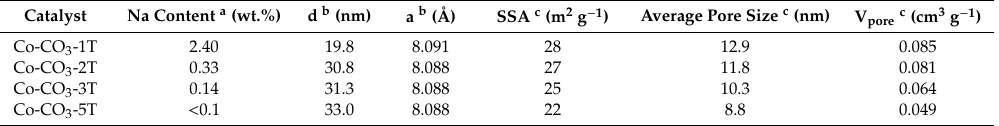
Table 1. Results from physico-chemical characterizations.